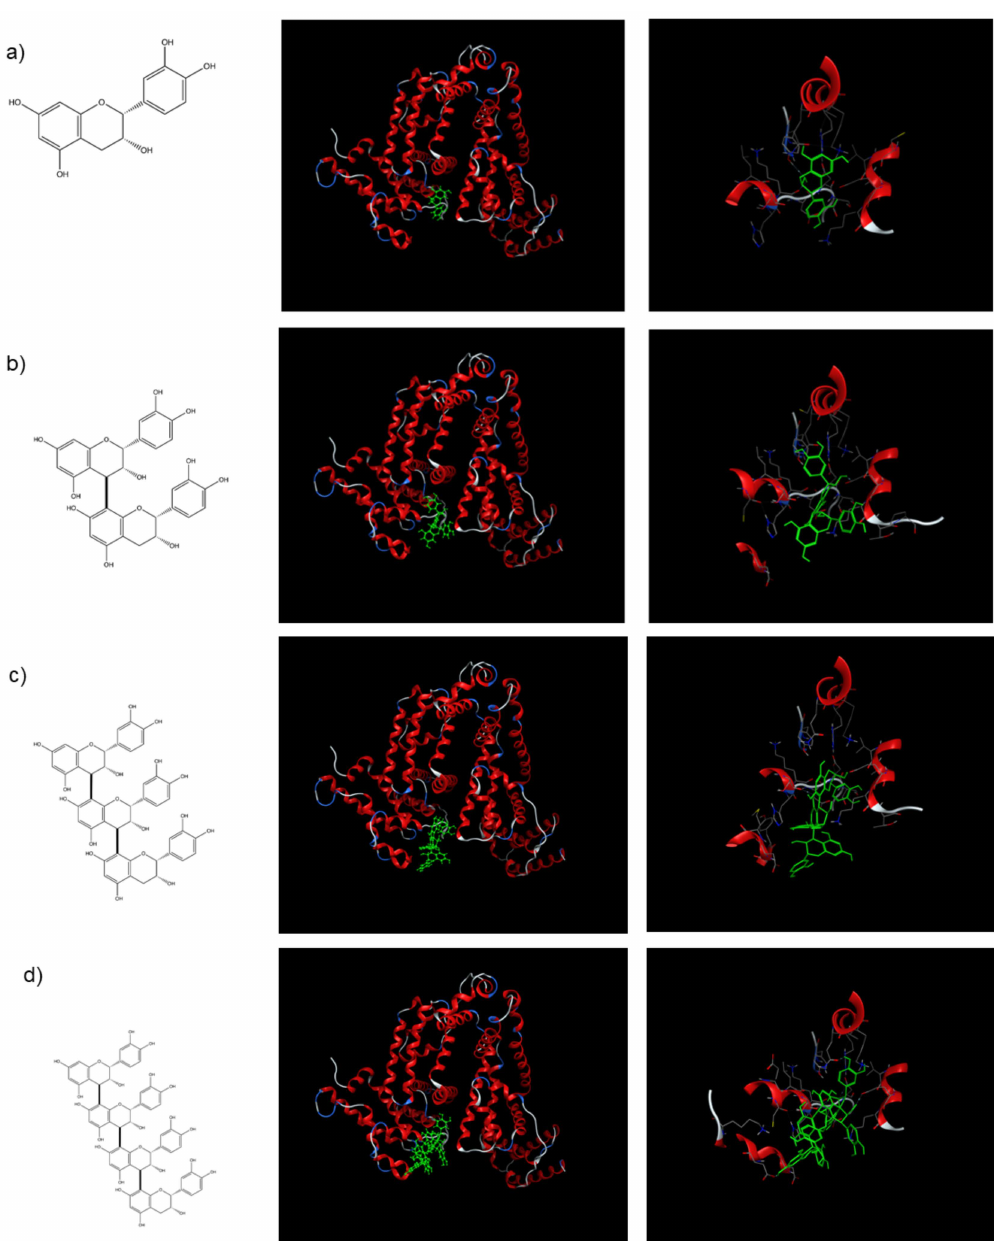
Figure 3. Chemical structure and lowest-energy docked poses of ( − )-epicatechin ( a ), procyanidin B2 ( b ), procyanidin C1 ( c ), and cinnamtannin A2 ( d ) with BSA. Docked poses reveal the entire ribbon structure of the protein shown in the left panel. The right panel shows close-ups of the docked